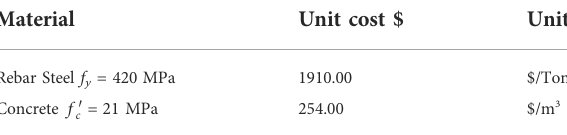
TABLE 4 Material costs for columns and beams (Currency: US dollar). TABLE 5 Concrete and reinforcement steel stress-strain